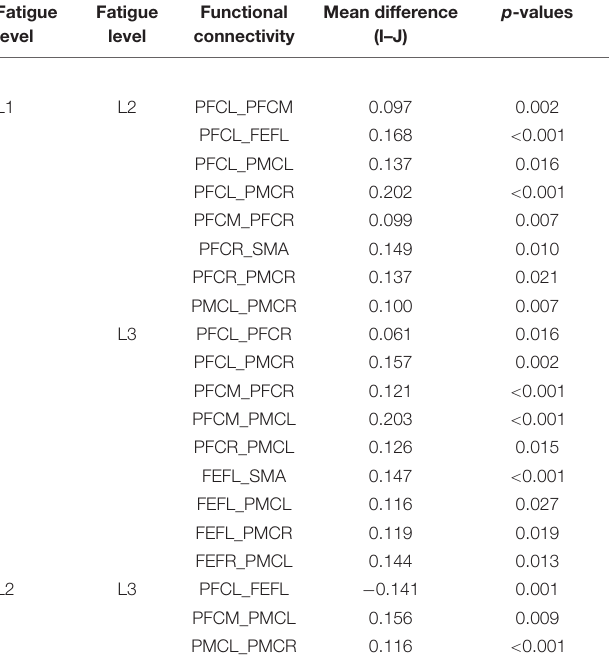
TABLE 3 | Post-hoc analyses among fatigue levels in band frequency III. Fatigue